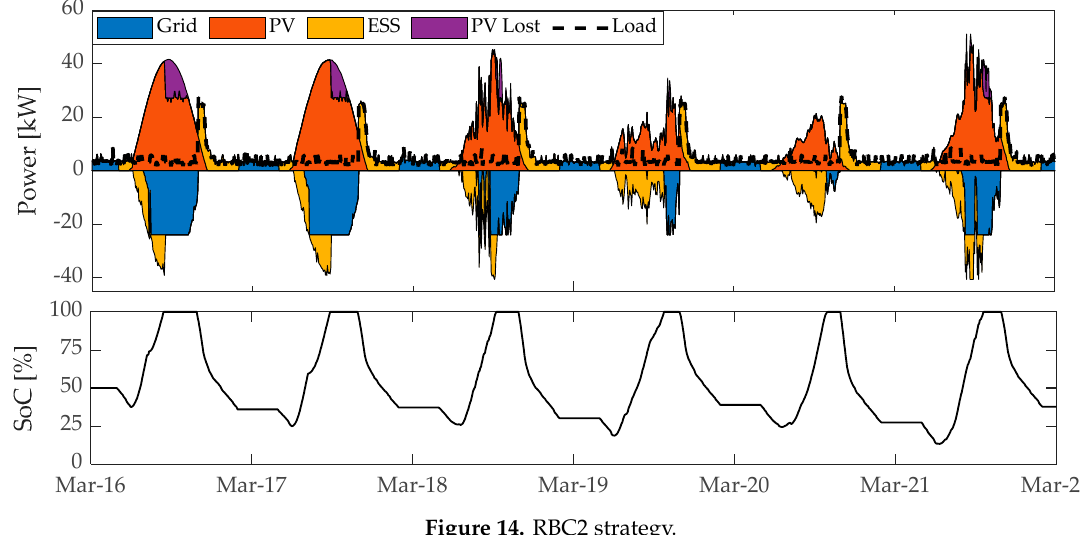
Figure 14. RBC2 Figure 14. RBC2 strategy. Figure 14. RBC2 strategy.